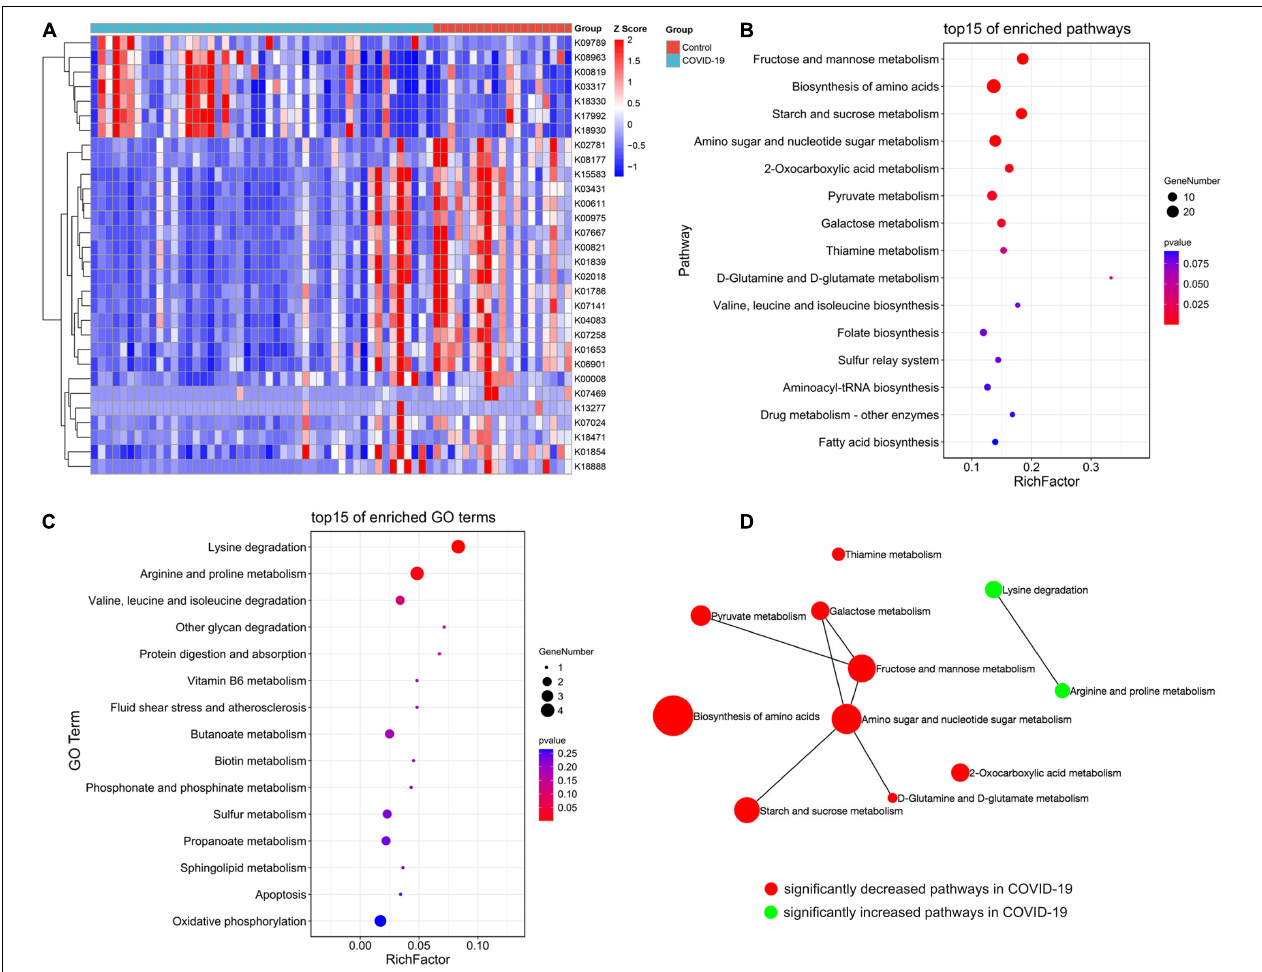
FIGURE 4 | Crucial KEGG orthology and pathways related to COVID-19. (A) A heat map shows 30 KO modules overrepresented between the COVID-19 patients and healthy controls, including 7 increasing modules and 23 decreasing modules in disease patients. (B) A bubble chart showing the top 15 enriched pathways with 9 significantly decreased KEGG pathways in COVID-19. (C) A bubble chart showing the top 15 enriched GO terms with 2 significantly increased GO term in COVID-19. (D) A network of significantly increased and decreased pathways of COVID-19